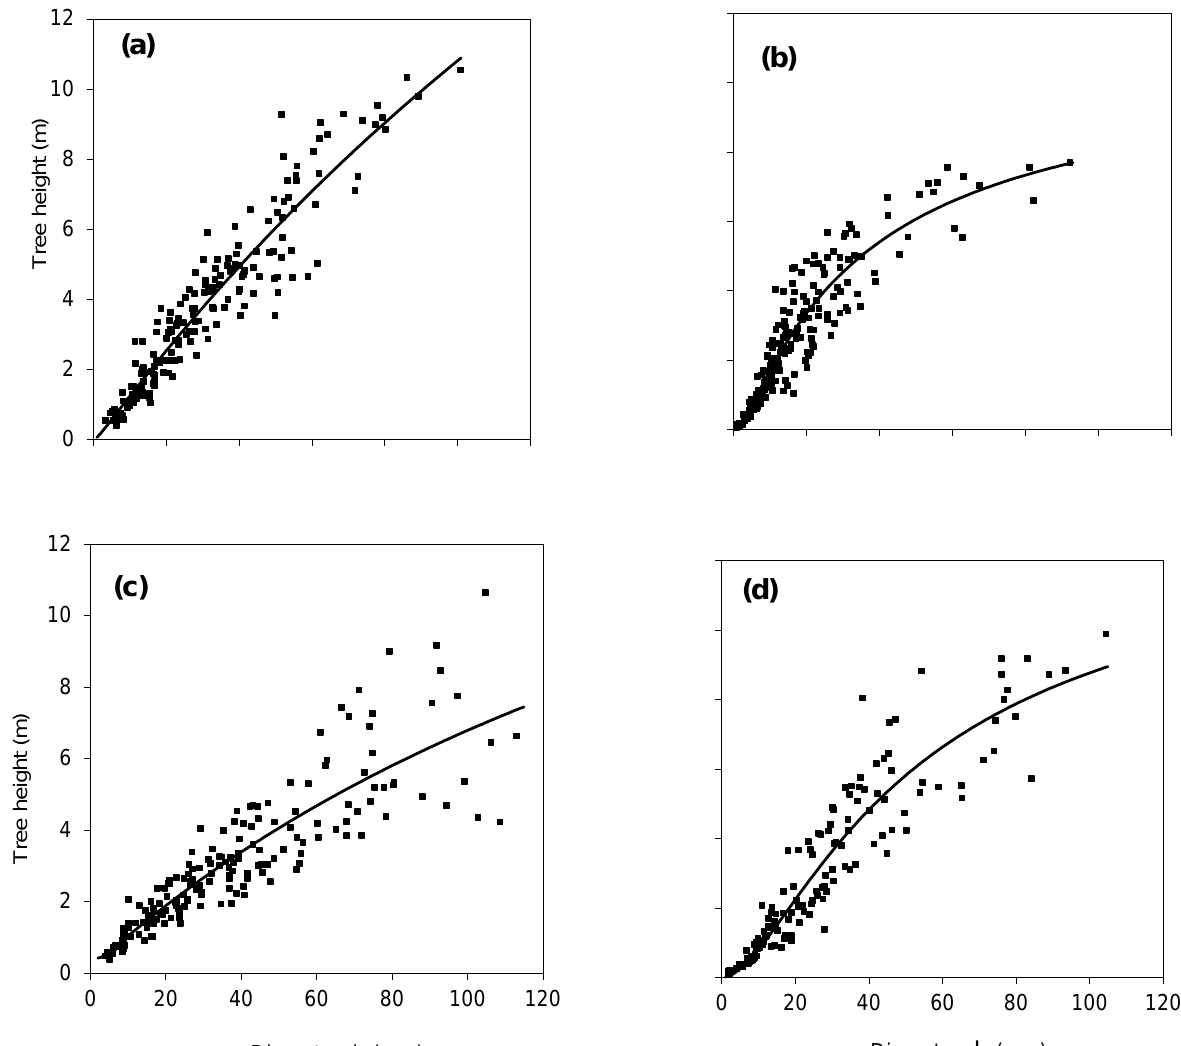
Figure 1. Relationships between diameter at stem base d 0 and tree height for four broadleaved species, specifically common aspen ( Populus tremula L.) ( a ), European hornbeam ( Carpinus betulus L.) ( b ), silver birch ( Betula pendula Roth. ) ( c ) and sycamore ( Acer pseudoplatanus L.) ( d ). Equation (1), its parameters and statistical characteristics are given in Table 1.